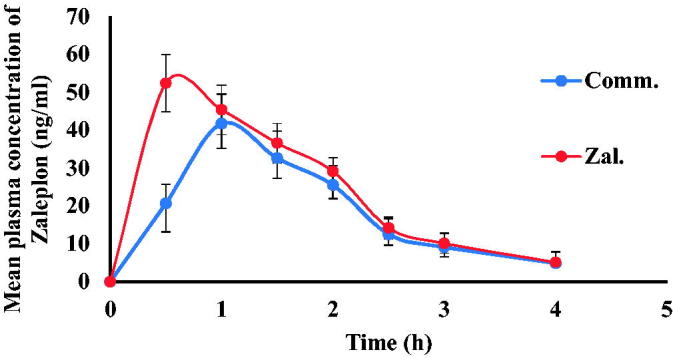
Mean plasma concentration of Zal-SNEDDS and commercial product.